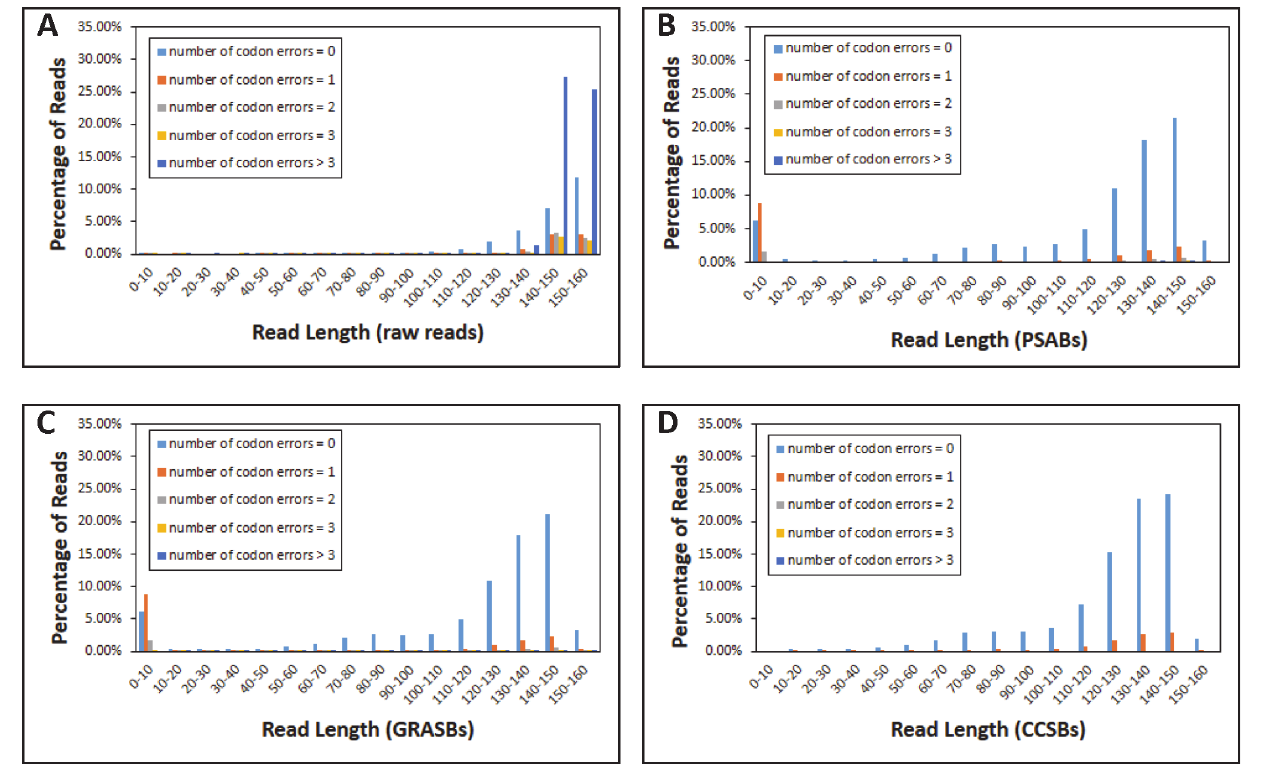
Fig 1. The distribution of codon errors as a function of the read lengths in M237I sample set in (A) Raw reads, (B) PSABs, (C) GRASBs, and (D) CCSBs.